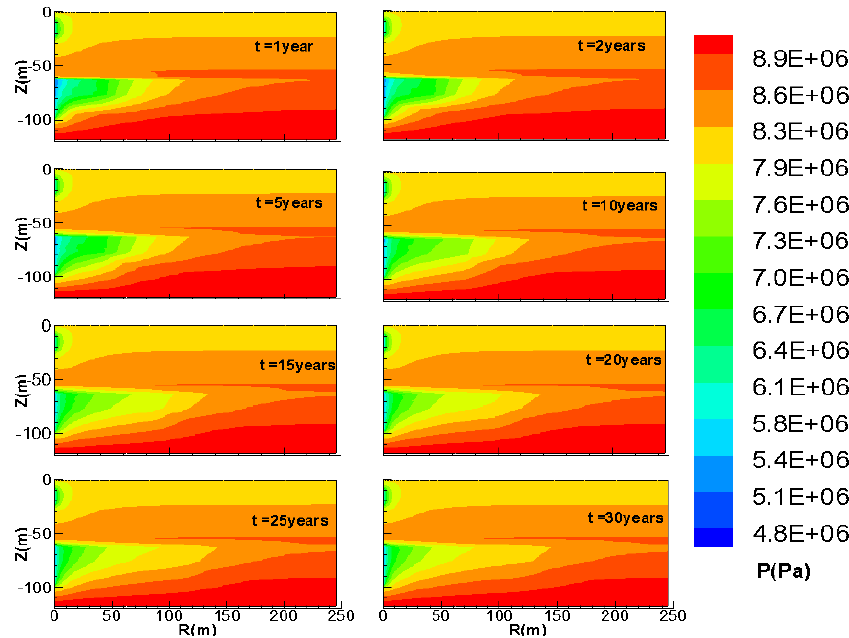
Figure 9. Reference case: evolution of the pore pressure ( P) distribution overtime.